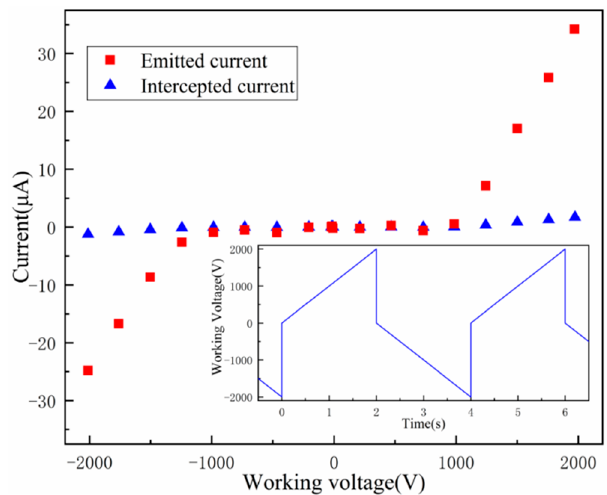
Figure 12. I–V characteristics for single ILET.